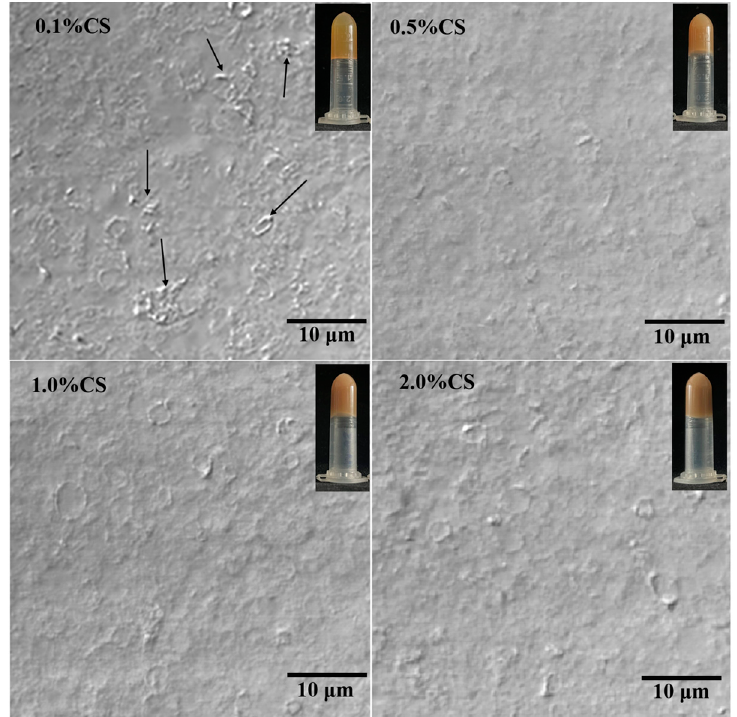
Figure 5. Appearance and microstructure of oleogels from COBET with different CS content under CLSM using bright-field imaging mode.